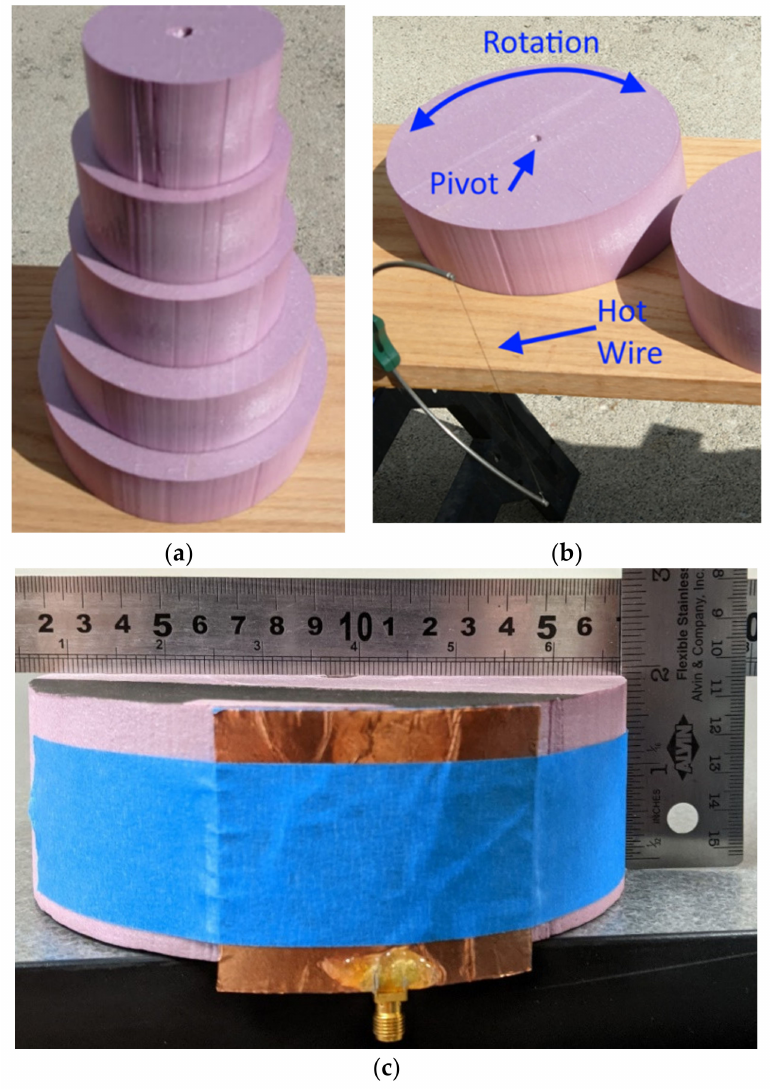
Figure 8. ( a ) Curved supports were produced with radii of 43, 50, 60, 75, and 88 mm (sorted from top to bottom in the figure, respectively). All supports were 50.8 mm thick; ( b ) foam supports of various radii were fabricated with a hot wire cutter and a rotational fixture; ( c ) the antenna was affixed to curved support discs. The radiating element (patch) is facing toward inward and the ground plane (shown) is facing outward in the